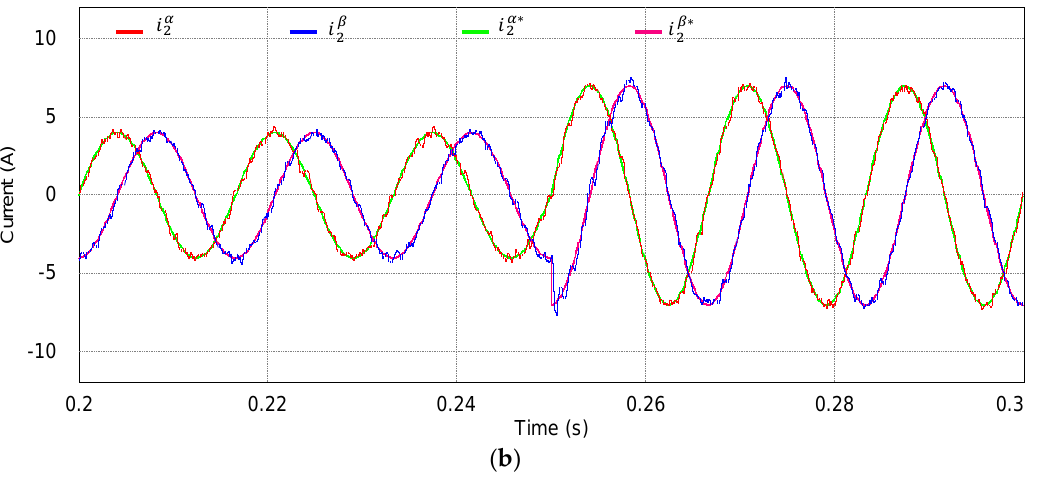
Figure 12. Simulation results for the proportional-resonant plus harmonic compensator (PR + HC) control scheme under step change. ( a ) Three-phase grid-side current waveforms; ( b ) current references and grid-side current responses at the stationary frame.